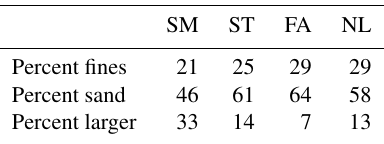
Table 1. Percent of grain sizes by mass determined from sieve anal- ysis of samples collected using a ∼ 200cm 3 sample at locations in the middle of the south aspect slope (SM), the toe of the south as- pect slope (ST), flat aspect (FA), and low on the north aspect slope (NL). Fines are considered less than 0.074mm, sand is larger than fines and less than